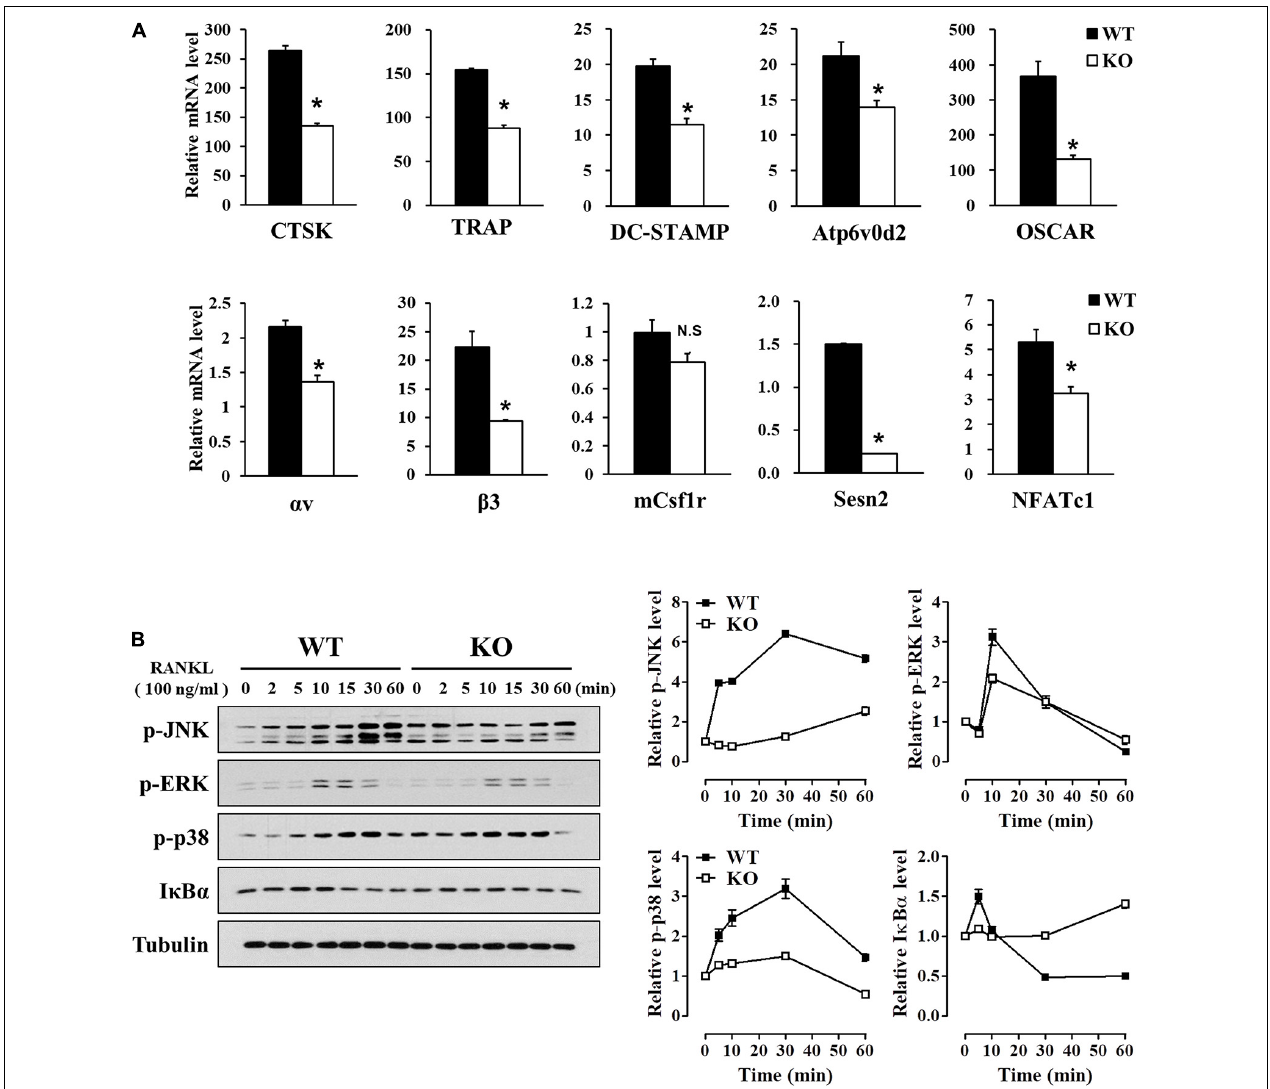
FIGURE 3 | Reduced expression of osteoclast differentiation marker genes in Sesn2 KO mice. (A) Expression of mRNAs for the master regulators of osteoclastogenesis were measured on 2 days after RANKL treatment. Osteoclastogenesis-related gene expression diminished in Sesn2 KO BMMs during osteoclast differentiation ( n = 4). Data were expressed as mean ± S.E.M. * p < 0.05 compared with WT. N.S. = not significant. (B) BMM cells were treated with 100 ng/ml RANKL for the period indicated. Protein expression of p-JNK (90 ∼ 110 kDa), p-ERK (44, 42 kDa), p-p38 (41 kDa), and I κ B α (35 kDa) was quantified